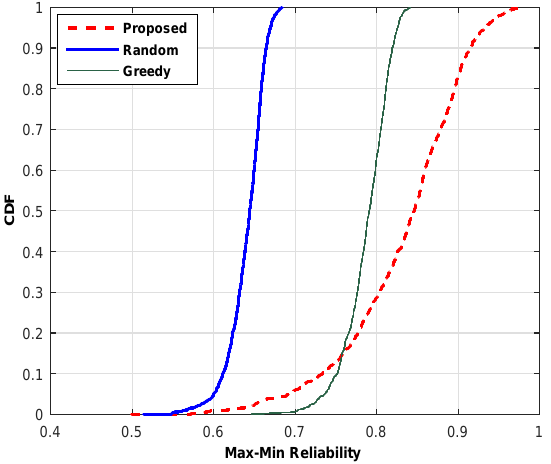
Figure 8. Cumulative distribution function of